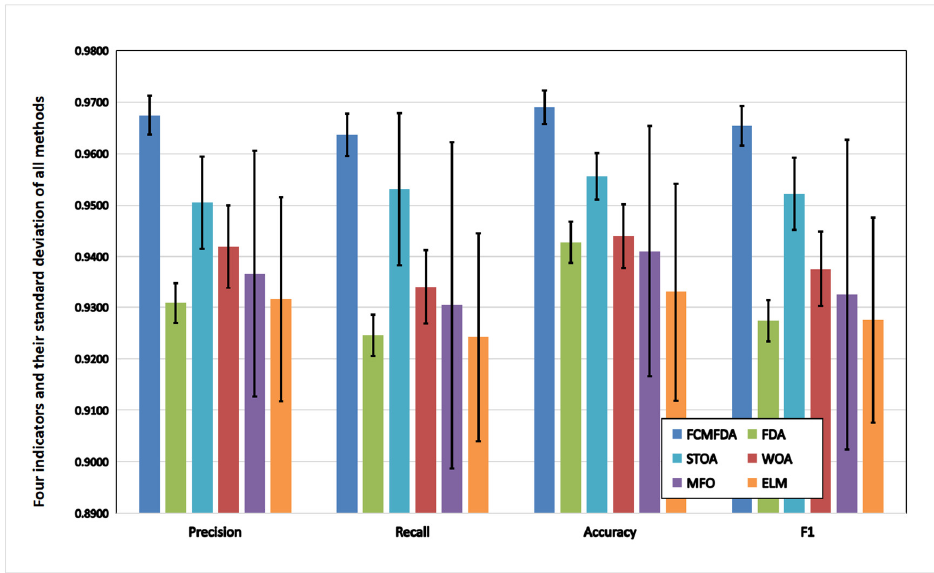
Figure 14. Four indicators and their standard deviation of all methods (URPC).